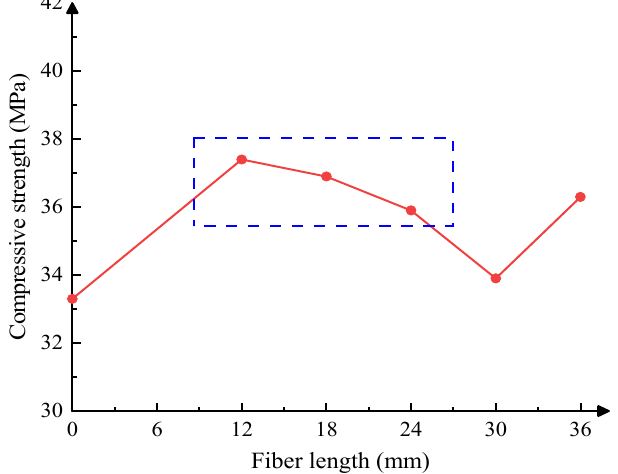
Figure 2. The 28 d compressive strength of the BRFC with different fiber lengths.